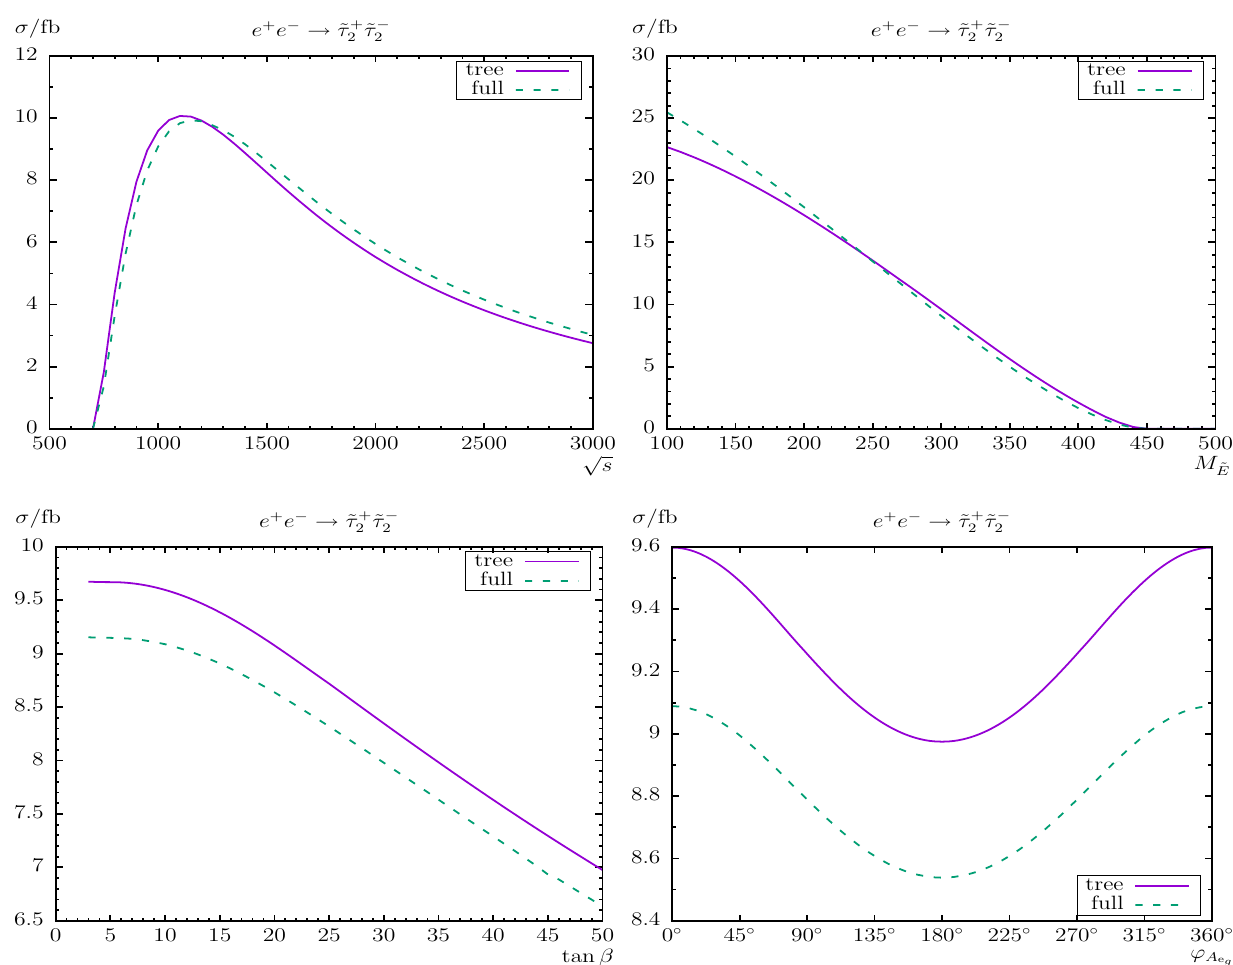
˜ τ − ) . Tree-level and full one-loop corrected cross sections are shown with parameters chosen according to S ; see Table 1. Fig. 17 σ( e + e − → ˜ τ + √ 2 2 s (left) and M ˜ The upper plots show the cross sections with (right) varied; the lower plots show t β (left) and ϕ A E energies are in